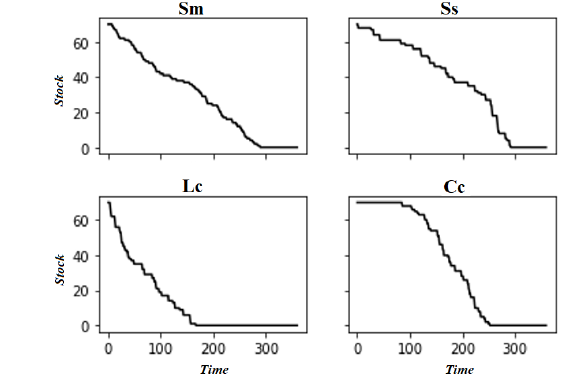
Fig. 8. Possible demand patterns for X = 70, T (cid:2870) = 350 Fig. 9. Possible stock consumptions, for X = 70, q = 80 ad T (cid:2870) = 250